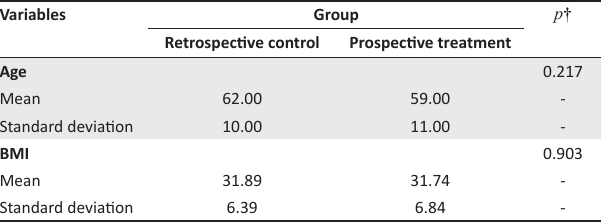
TABLE 1: Patient demographics as per age and body mass index ( n = 120). Variables